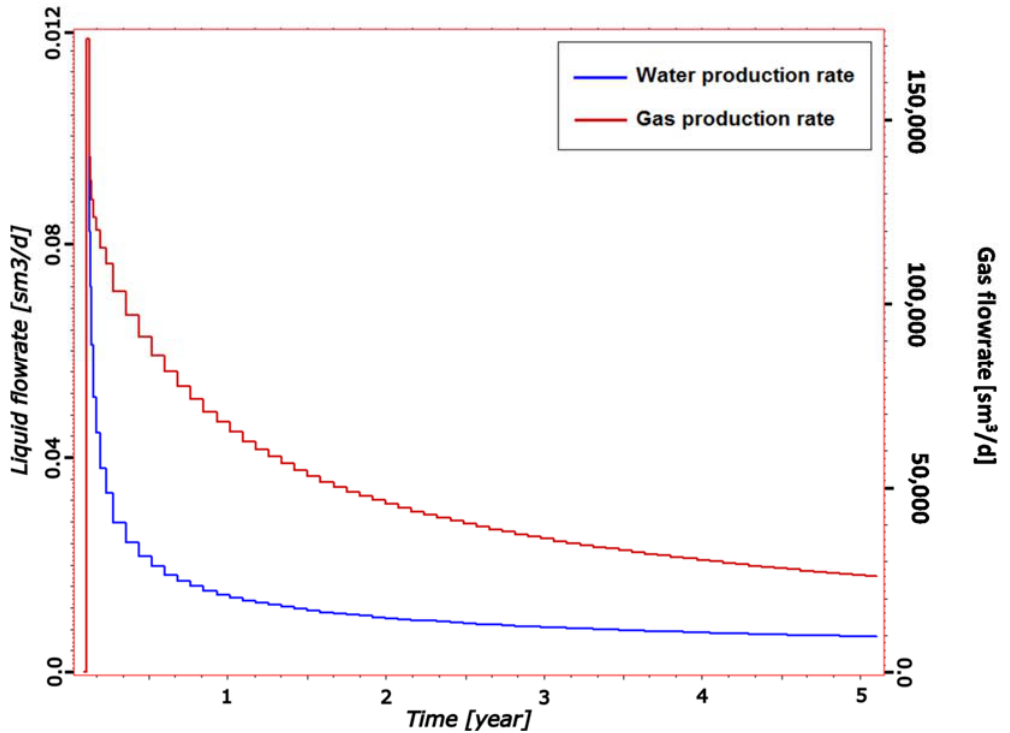
Figure 6. Daily production rates of water and methane during the simulated extraction of CBM for the entire model of the deposit using three directional wells.